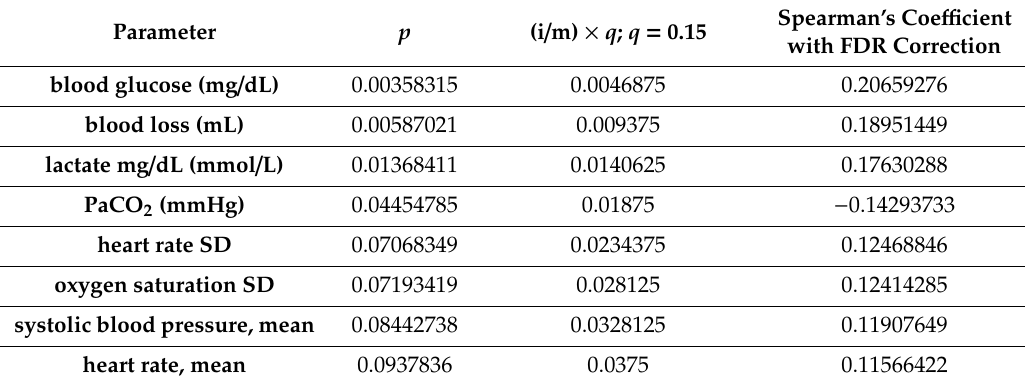
Table 3. Correlations of hemodynamic parameters and infarct